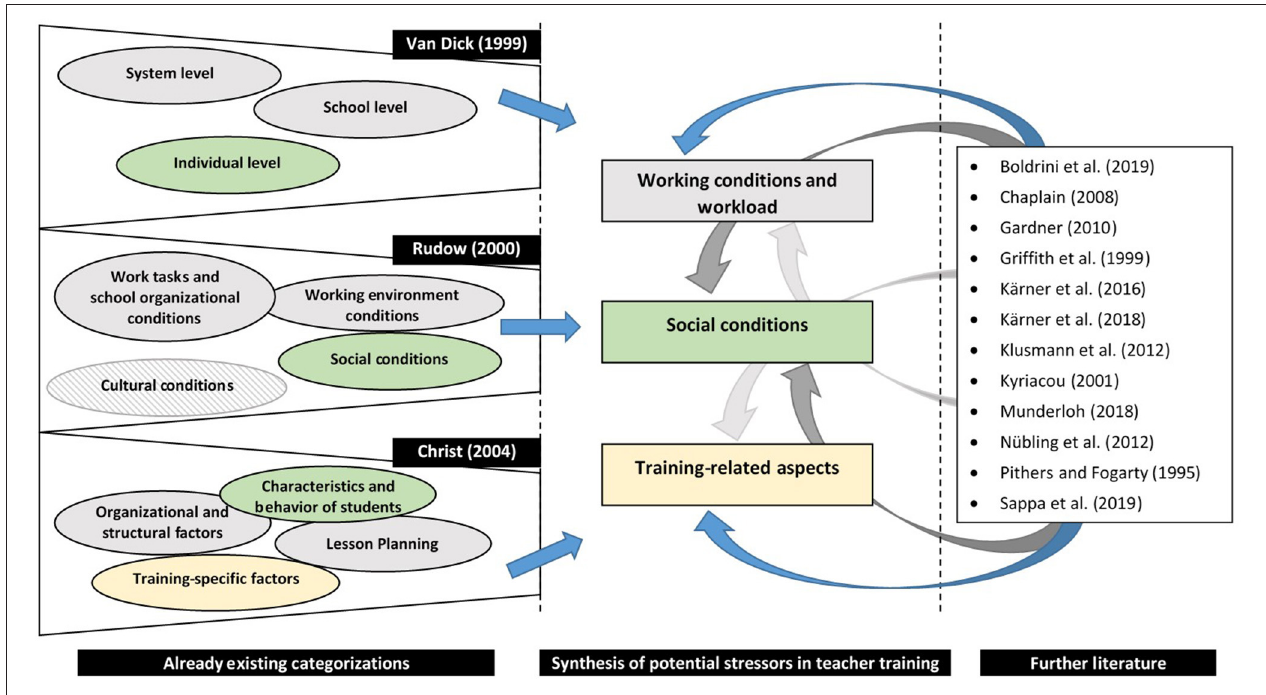
FIGURE 2 | Three main sources of potential occupational stressors in VET teacher